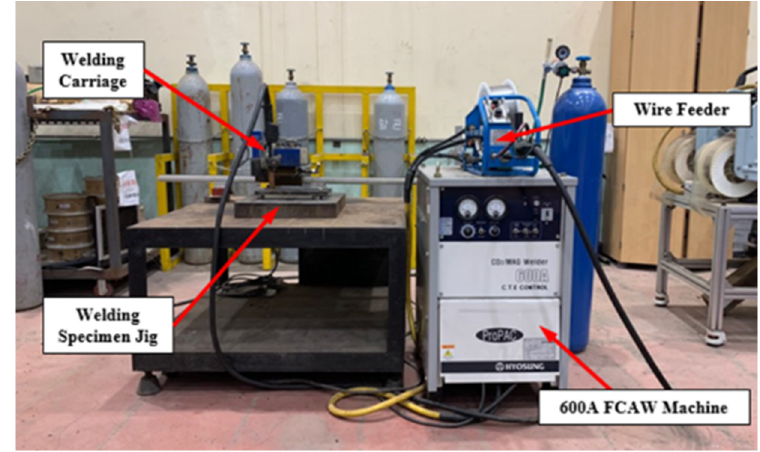
Figure 2. Flux core arc welding